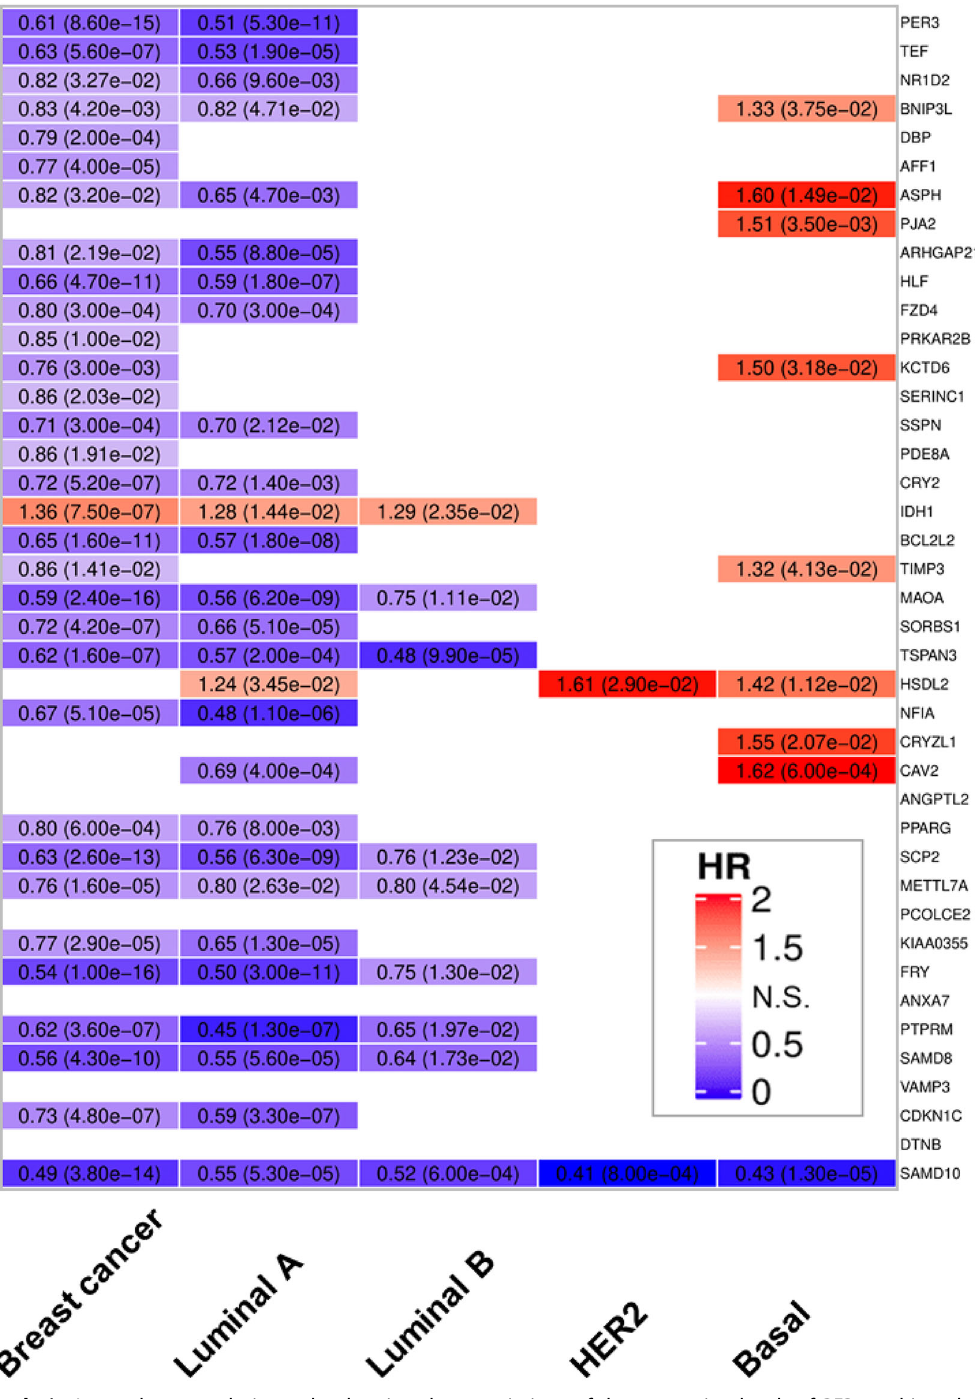
Fig. 5 Survival analysis. Logrank test analysis results showing the associations of the expression levels of PER3 and its robust co-expression partners with relapse-free survival in samples derived from all breast cancer subtypes and each intrinsic breast cancer subtype (i.e., luminal A, luminal B, HER2, and basal). Each cell shows the Hazard Ratios (HR) and the p -values derived from the analyses. Cell color intensities are proportional to HR values. Blue hues indicate genes for which low expression levels are associated with shorter relapse-free survival times, whereas red hues indicate genes for which high expression levels are associated with shorter relapse-free survival times. Non-colored cells indicate no association between gene expression and breast tumors that undergo genetic alterations on chromosome tumor cells. This idea is supported by our data showing a region 1p36 preferentially lose the more common 4 repeat allele, preferential allelic imbalance at the PER3 locus and by the and retain the PER3 5 repeat allele. This preferential retention association found between low PER3 expression levels and worse could be due to the fact that changes in PER3 function derived disease-free survival outcomes in Luminal A breast cancers. from the presence of an additional VNTR repetition have a Combined data of patient samples and cell lines suggest that